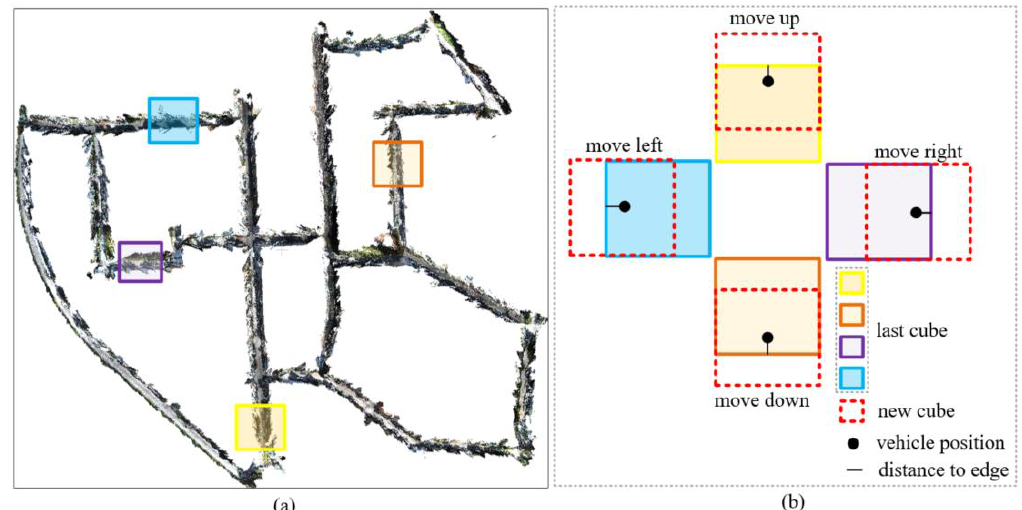
Figure 2. The diagram of adaptive priori map segmentation from top view. ( a ) Adaptive priori map segmentation from sequence 00 of the KITTI dataset; ( b ) different motion conditions for the vehicle.